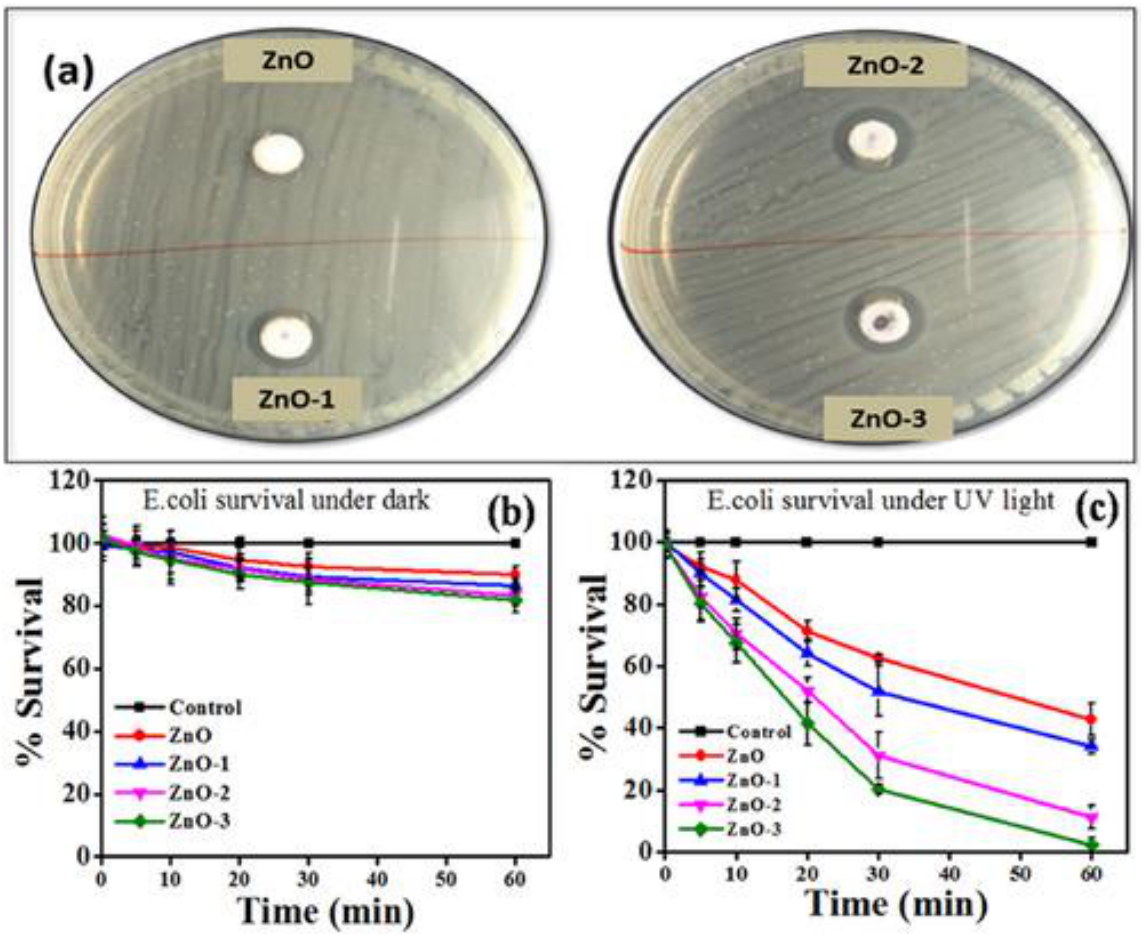
Figure 6. Antibacterial activity of ZnO glasses. ( a ) Disk diffusion test. Survival (in %) of E. coli after treatment with ZnO glasses (plate form) ( b ) under dark and ( c ) under UV irradiation (360 nm). Reprinted with permission from Ref. [48].